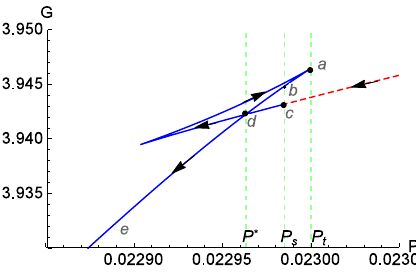
Fig. 6 The Gibbs free energy (Eq. (3.15)) at q = 2, e = 1 . 5, and T = 0 . 13960. P ∗ corresponds to the pressure of the intersection (point d ), P t corresponds to the pressure of the cusp (point a ), and P s cor- responds to the pressure of point c with zero entropy. The red dashed curve corresponds to the negative entropy. A black arrow indicates an increasing trend of the horizon radius r